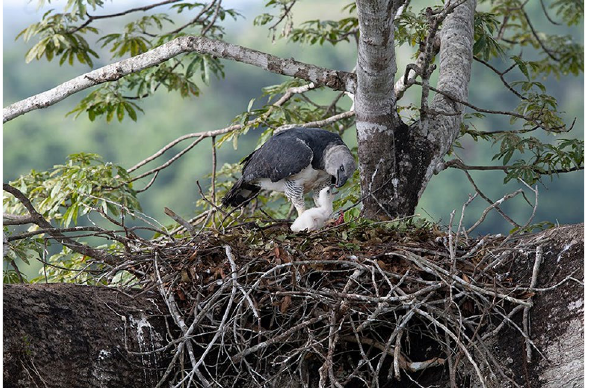
Figure 1. Harpy eagle female protecting an eaglet at her nest in an emergent kapok tree ( Ceiba pentandra, Bombacaceae). Photo: Barbara